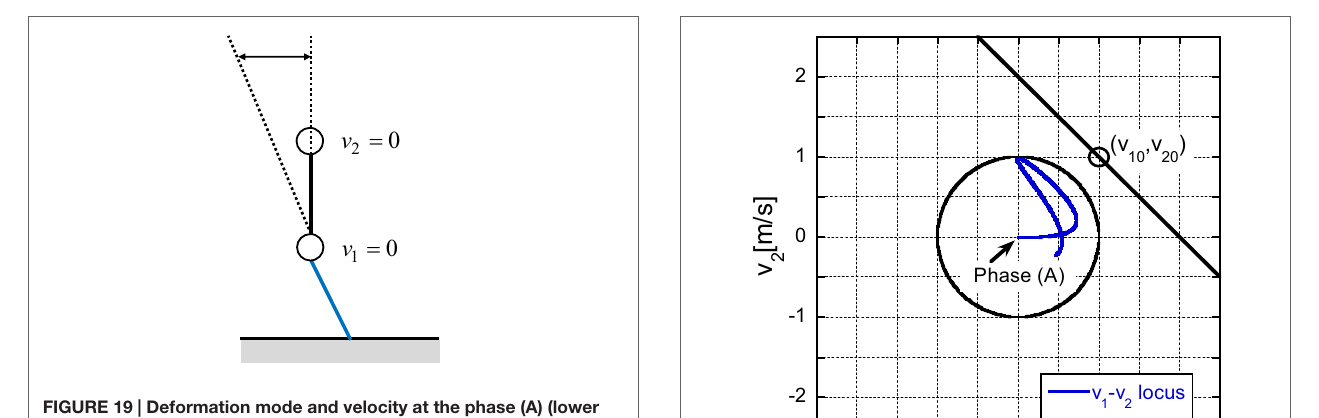
FigUre 19 | Deformation mode and velocity at the phase (a) (lower bound case).